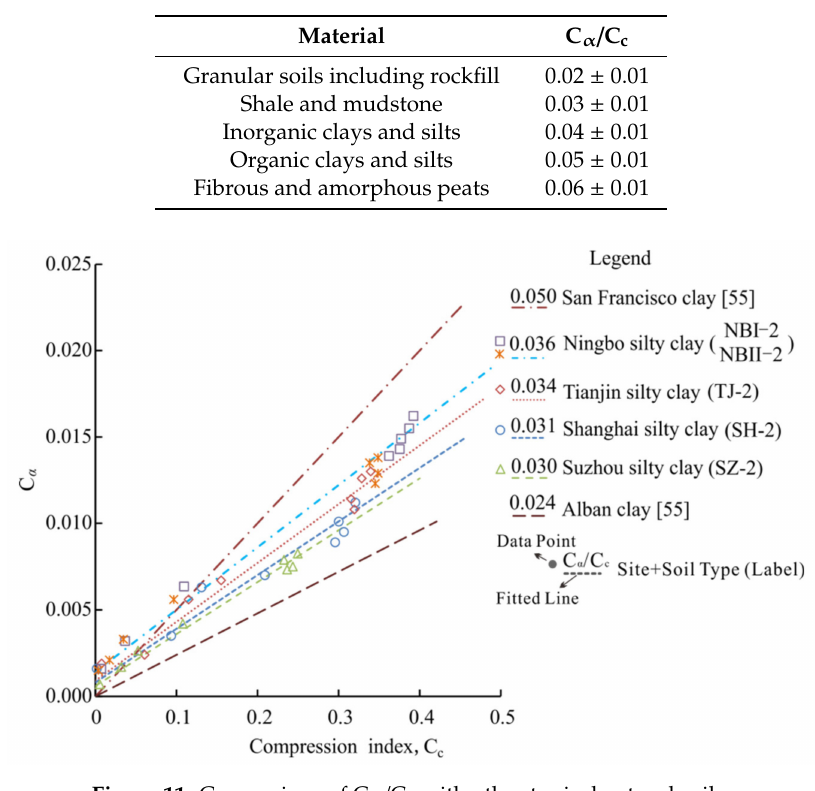
Figure 11. Comparison of C α / C c with other typical natural